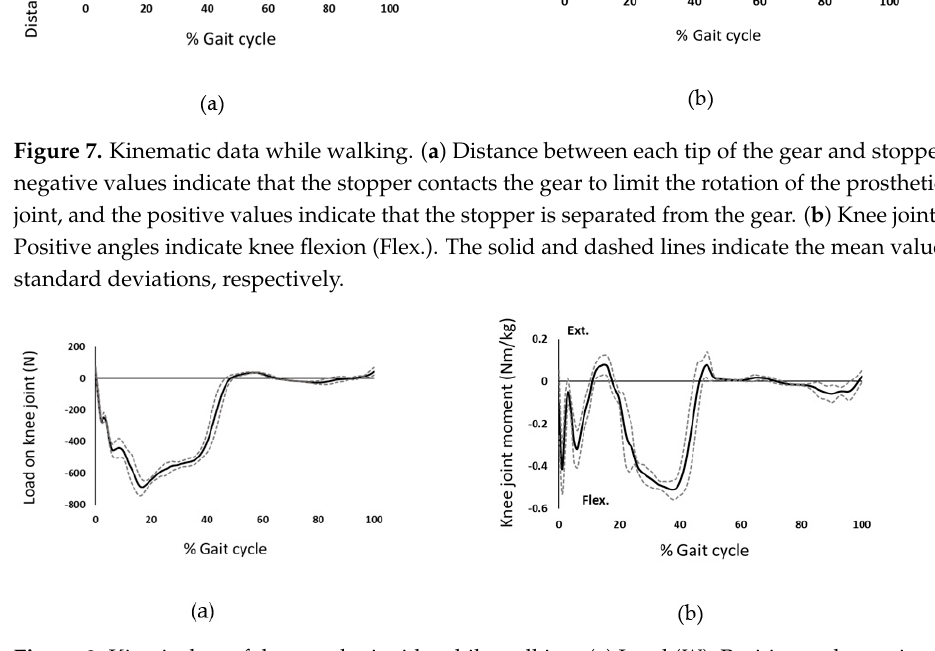
Figure 8. Kinetic data of the prosthetic side while walking. ( a ) Load ( W ). Positive and negative values indicate the pulling and compressive forces, respectively. ( b ) Knee joint moment of the prosthesis side. Positive value indicates knee extension moment (Ext.). The solid and dashed lines indicate the mean values and standard deviations, respectively.